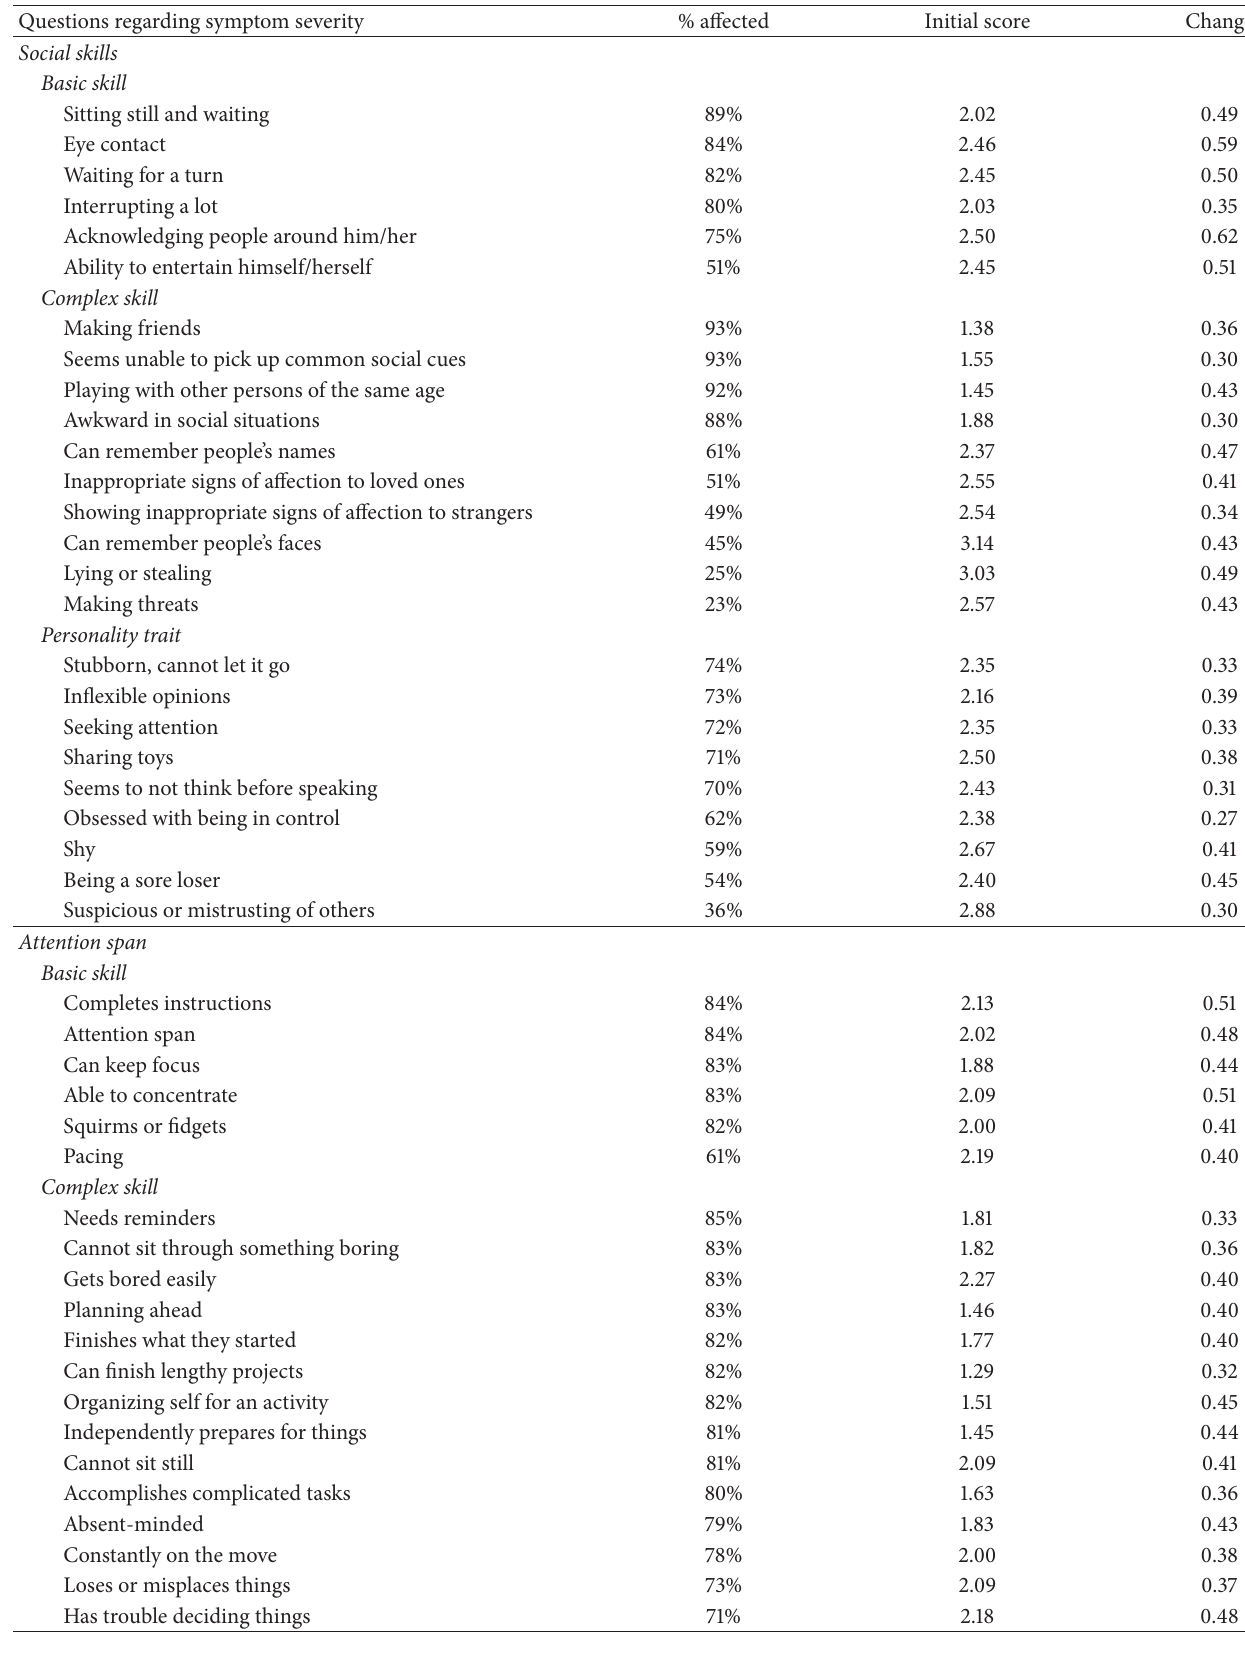
Table 1: Specific questions for parental